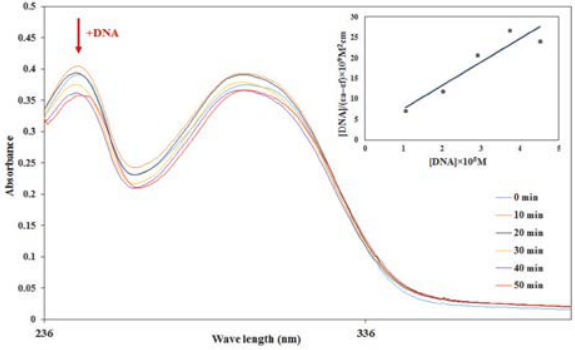
Figure 2. Absorption spectra of complex I with increasing concen- tration of HS–DNA after incubation for 10 min for each addition at 37 °C in phosphate buffer (pH 7.2). Inset: Plots of [DNA]/( ε a – ε f ) versus [DNA] for the titration of DNA with gold(III) complexes.